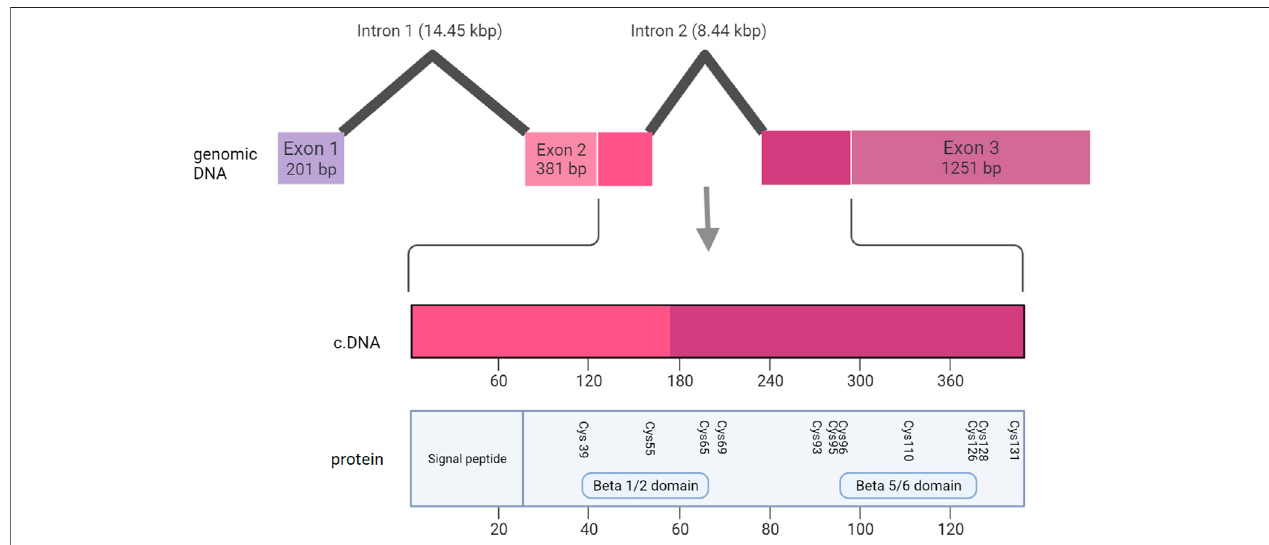
FIGURE9| Schematic representation oftheNDPgene,showing therelationshipbetweenthegenomic DNA, thecodingDNA(cDNA) and thefunctional regionsof the NDP protein.